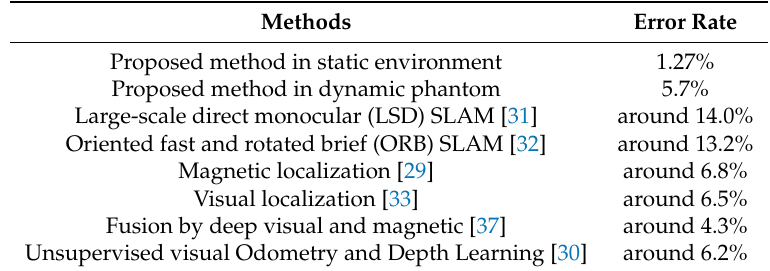
Table 3. Comparisons between the proposed method and state-of-the-art